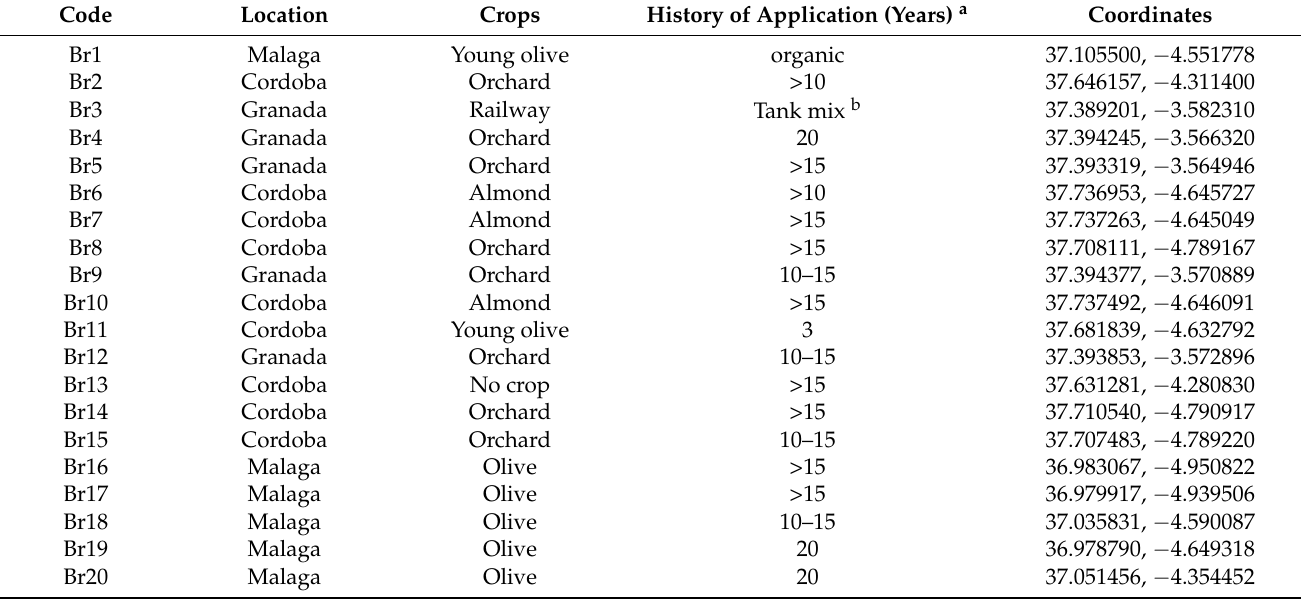
Table 1. Characteristics of Bromus rubens populations used in this work, code assigned to each population, history of application, and